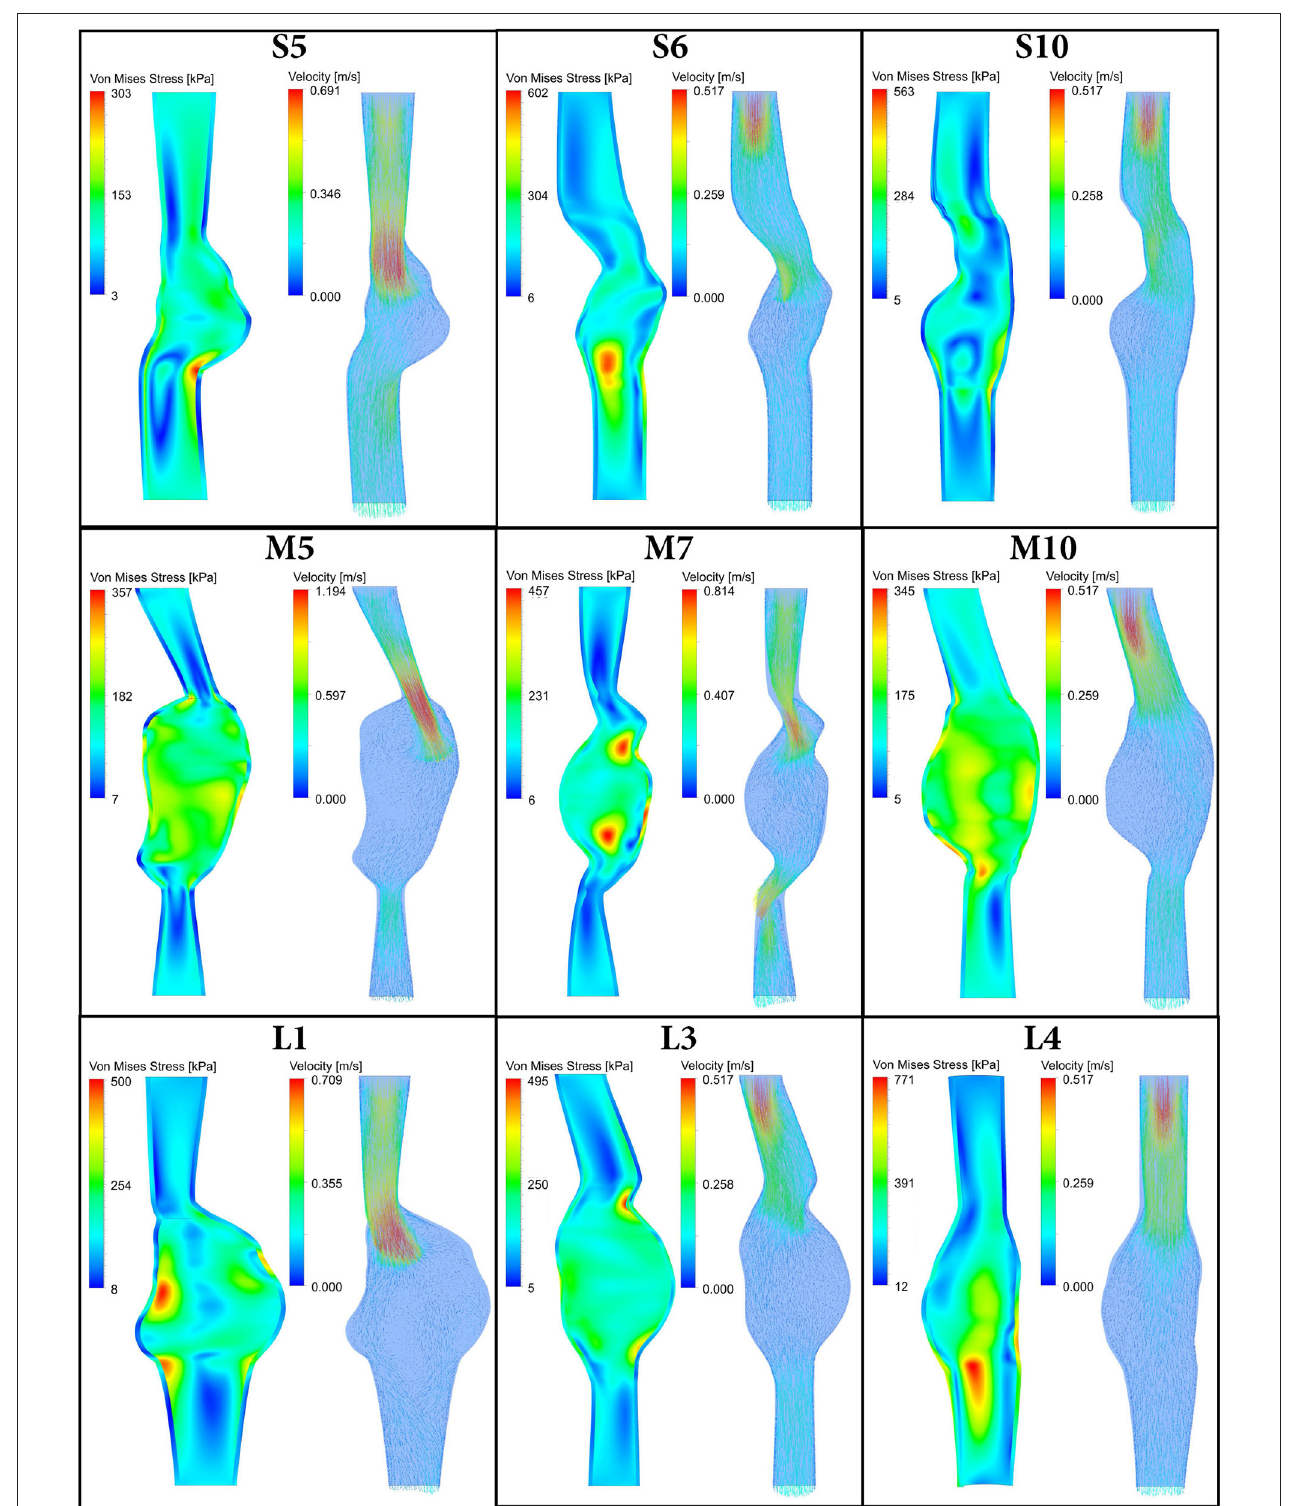
FIGURE 3 | Systolic Von Mises stress (left) and systolic velocity vectors (right) resulting from FSI simulations with PSE plotted on a longitudinal section of 9 representative patient AAA geometries. Note there is a time delay between systolic velocity (flow) and systolic stress, as illustrated in Figure 4 .